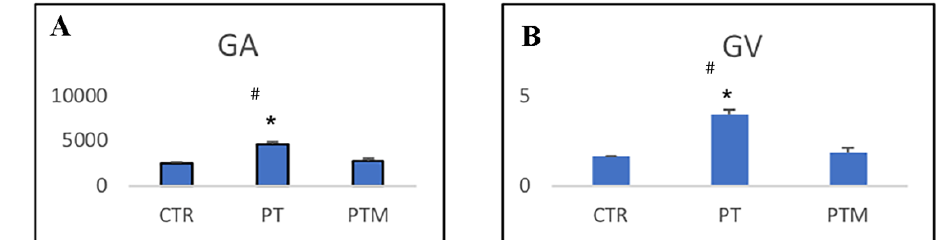
Figure 2. Glomerular morphometric changes in of control mice (CTR), pristane-LN mice (PT), pristane-LN mice treated with melatonin (PTM). ( A ) Glomerular area (GA), expressed as µm 2 , ( B ) Glomerular volume (GV), expressed as 10 6 µm 3 . *# indicate respectively statistically significant differences vs control and pristane-LN mice treated with melatonin: p < 0.05. CTR: control mice PT: pristane-LN mice PTM: pristane-LN mice treated with melatonin.